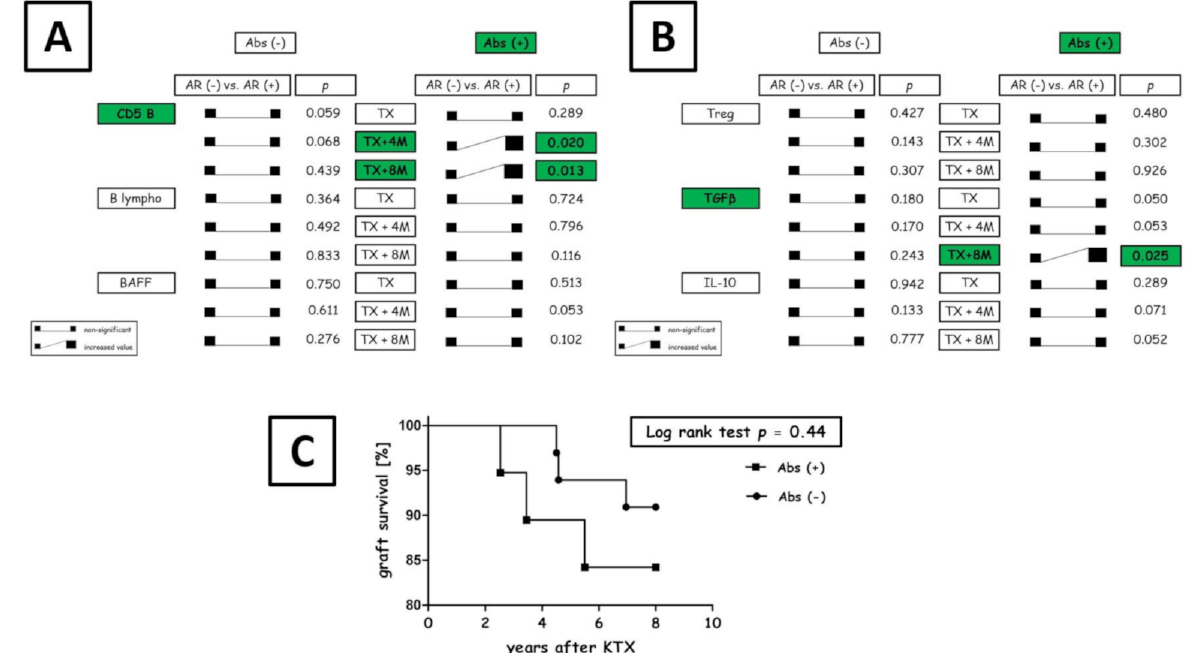
Figure 7. Graft survival rate at 8 y post-transplant. ( A , B ), the differences in CD5+ B cells, total B cell count, Tregs, IL-10, TGF β and BAFF across Abs − and Abs+ in respect to the acute rejection incidents limited to the transplantation, 4 and 8 months after. ( C ), graft survival rate was 90% for Abs − ( n = 33) and 84% for Abs+ ( n = 19) recipients. This difference was not significant based on both the log-rank test ( p = 0.44) and the Gehan-Breslow-Wilcoxon test ( p = 0.41). The hazard ratio was 0.51 (95% CI: